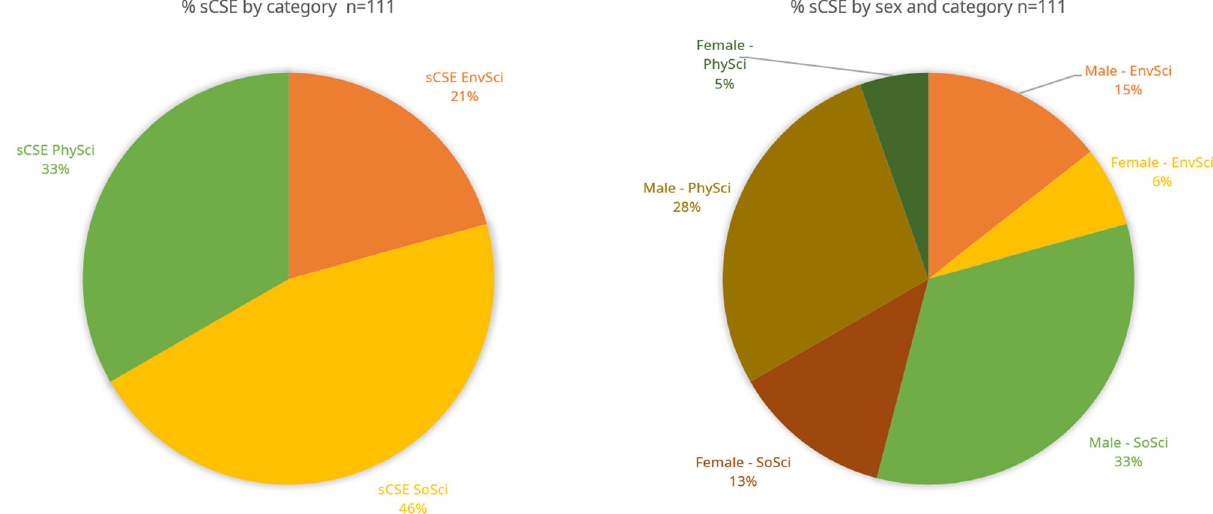
Fig. 1 Percentage of sCSE by category (left); and percentage of sCSE by sex and category (right). Source: Fundación Alejandro Ángel Escobar (2007, 2020). Note: EnvSci: Environmental Sciences and Sustainable Development ; SoSci: Social Sciences and Humanities ; PhySci: Physics and Natural Sciences